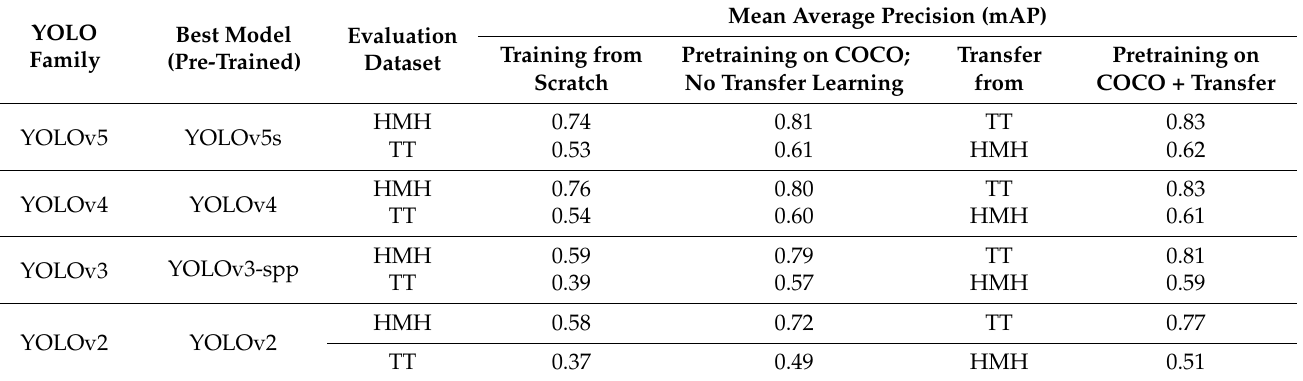
Table 5. Experiment V and VI results. Performance comparison between models trained from scratch, without transfer learning, and with transfer learning by location based on